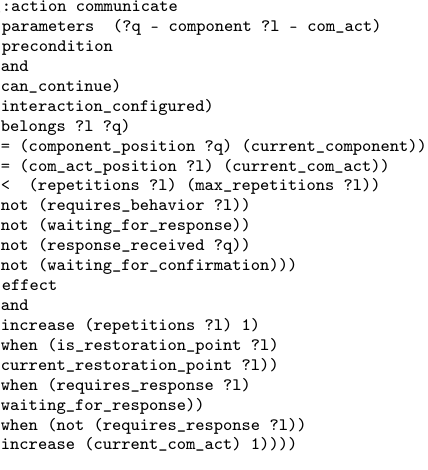
Figure 5. Example of domain